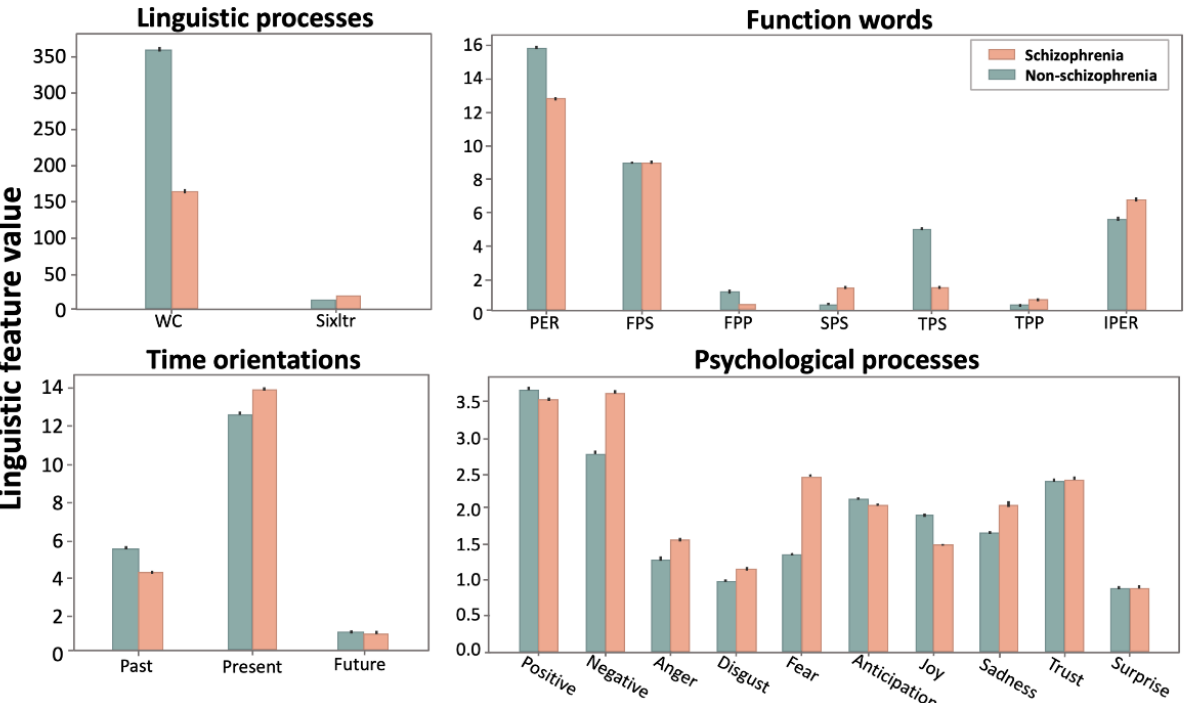
Figure 1. Comparison of the linguistic features between the schizophrenia and the non-schizophrenia (control) groups. Bars and error bars correspond, respectively, to averages and standard deviations across the linguistic values for each linguistic feature. WC = word count; Sixltr = words longer than six letters; PER = personal pronouns; FPS = first person singular; FPP = first person plural; SPS = second person singular; TPS = third person singular; TPP = third person plural; IPER = impersonal pronouns.